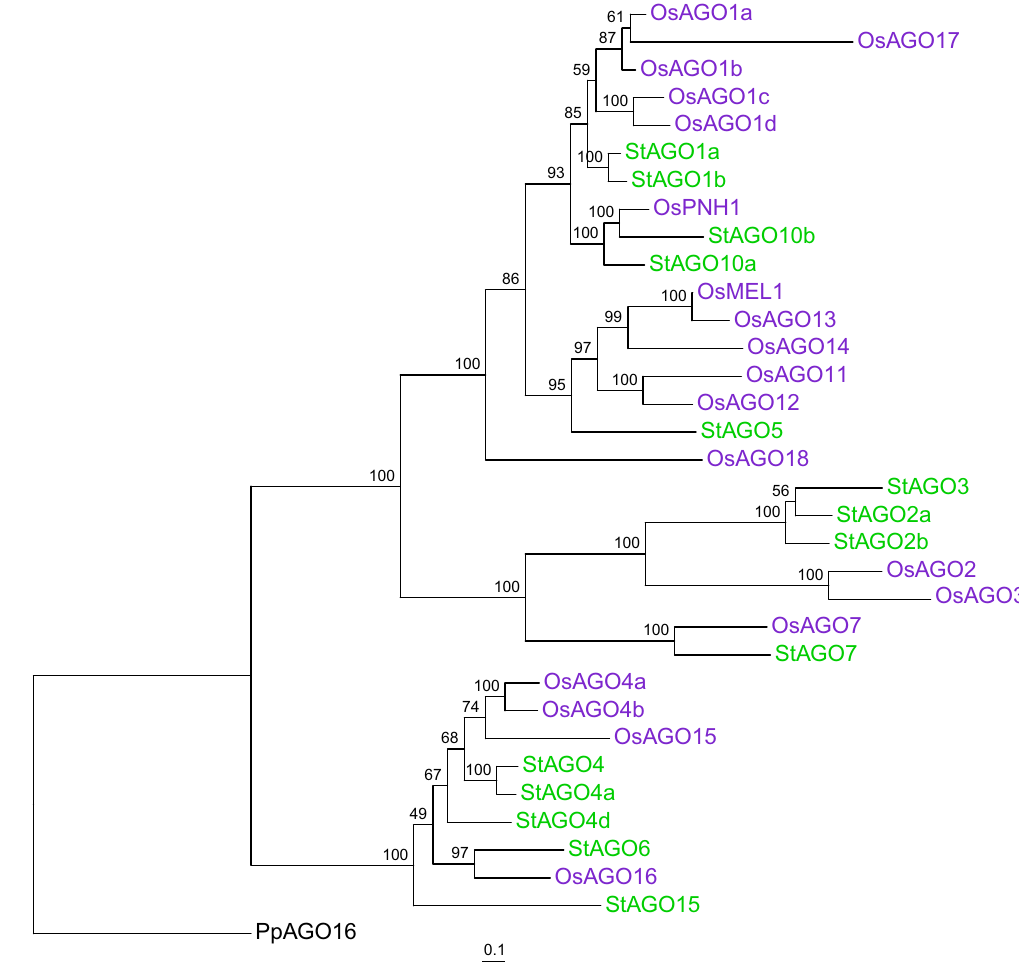
Figure 3. Maximum likelihood phylogeny (RAxML, model JTT + Γ, 150 replicates) of the Argonaute (AGO) family in potato (green) and rice (purple). Bootstrap values > 70% are indicated. Outgroup = Physcomitrella patens AGO16. Bar = number of substitutions per